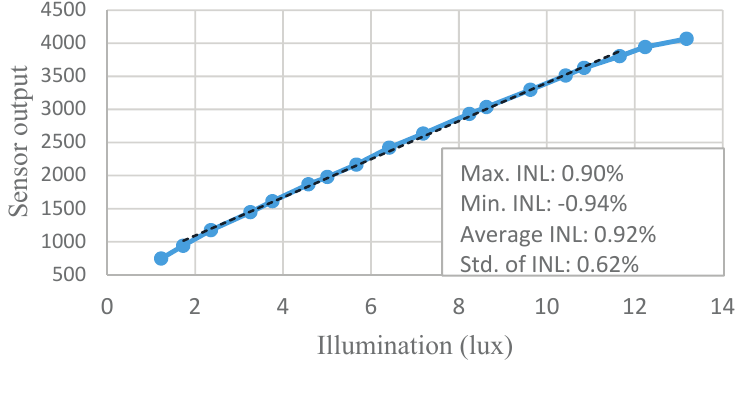
Figure 25. Measured SNR versus